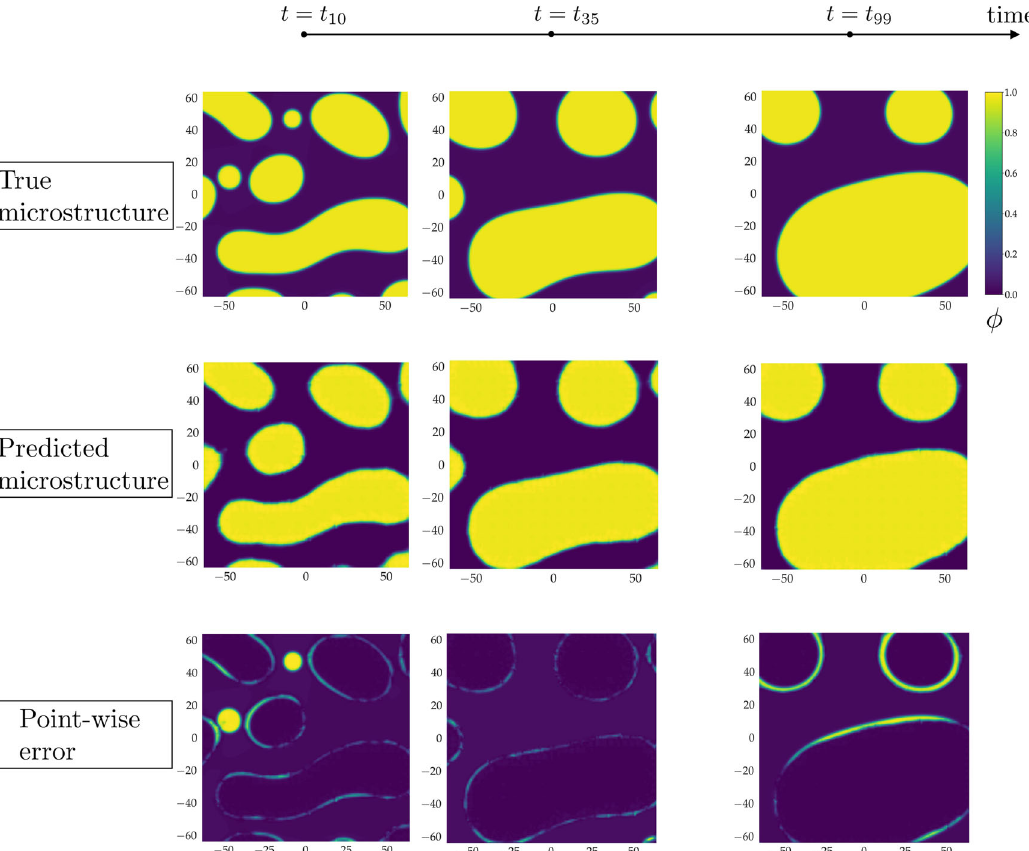
Fig. 2 Predictions of microstructure evolutions. The true (top row), predicted (middle row), and point-wise error (bottom row) for a microstructure realization evolving in time. The snapshots at time frames t = t 10 , t 30 , t 99 are shown here. The network used for this simulation has l d = 196, and uses the following network architecture: Branch network -- 2 × [conv(128, (3, 3))] + [3920]; Trunk network -- 2 × [100] +